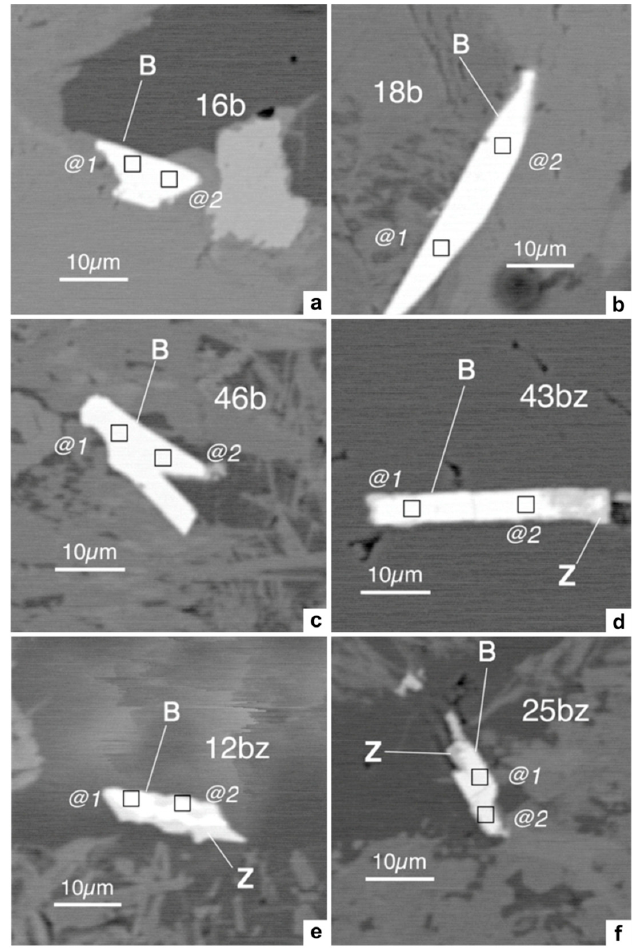
Figure 4. Back-scattered electron (BSE) images of baddeleyite (B, bright white) with varying degrees of alteration to zircon (Z, bright grey) from mafic sill X04-14-1. Approximate locations of the rastered analytical areas from the CAMECA1290-HR SIMS are indicated as 3 µm black squares. Pristine baddeleyite domains such as in ( a – d ) produced robust data. Alteration to zircon in 12bz@2 ( e ) and both spots in 25bz ( f ) yielded poor quality data and failed the data quality filters discussed in Section